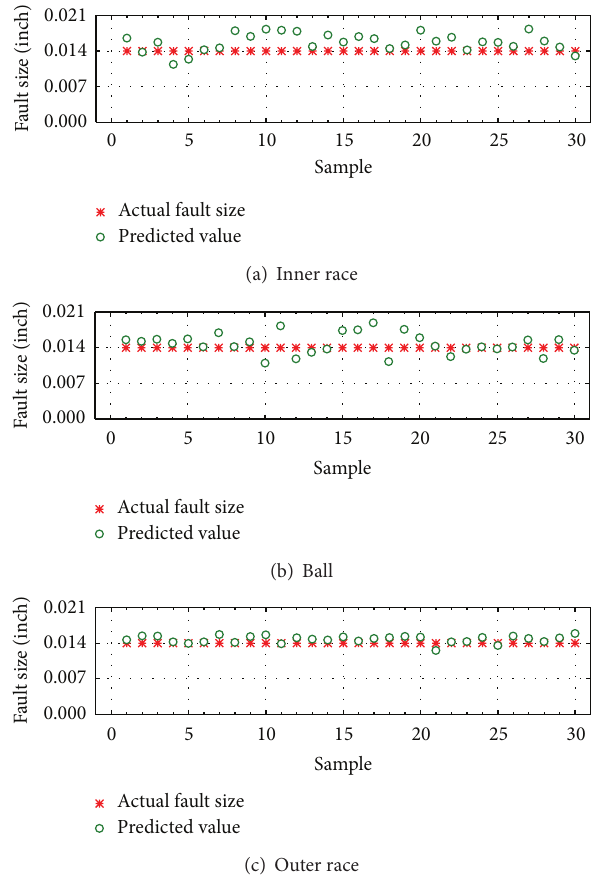
Figure 9: The prediction of fault size based on SVR.